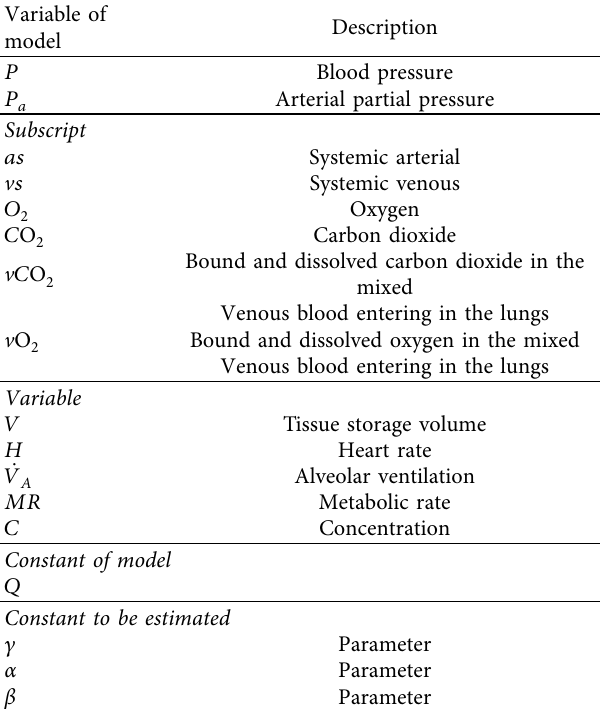
Table 1: Description of variables and parameters of the mathe- matical